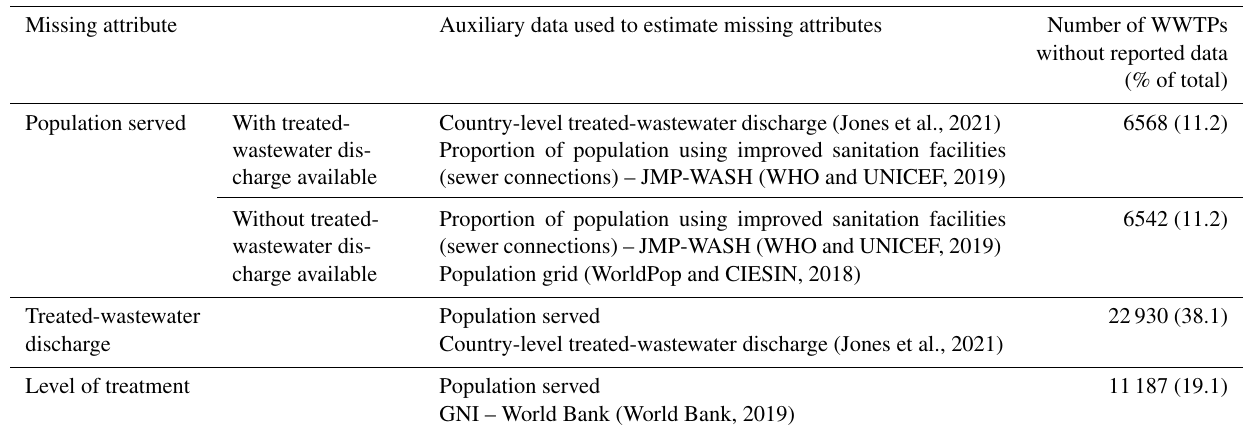
Table 2. Summary of approaches used to estimate missing WWTP attributes based on auxiliary data. Missing